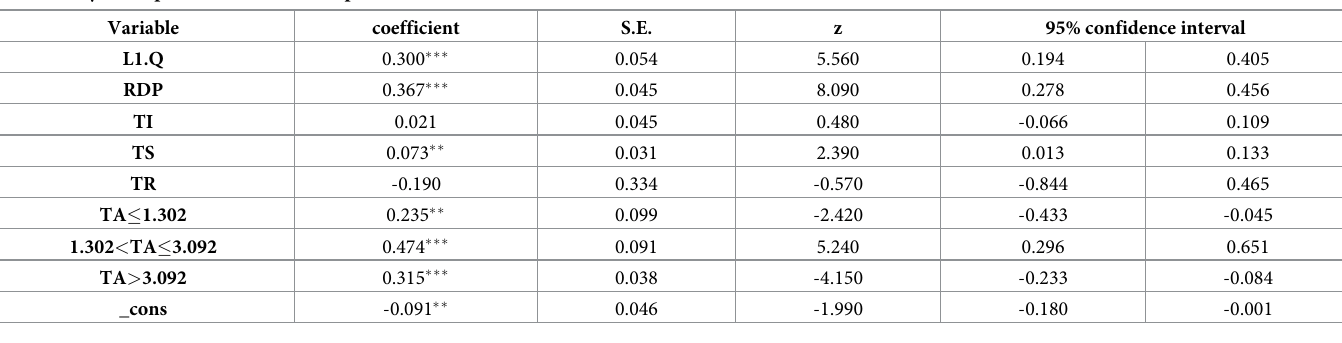
Table 5. Dynamic panel threshold model parameter estimation results.